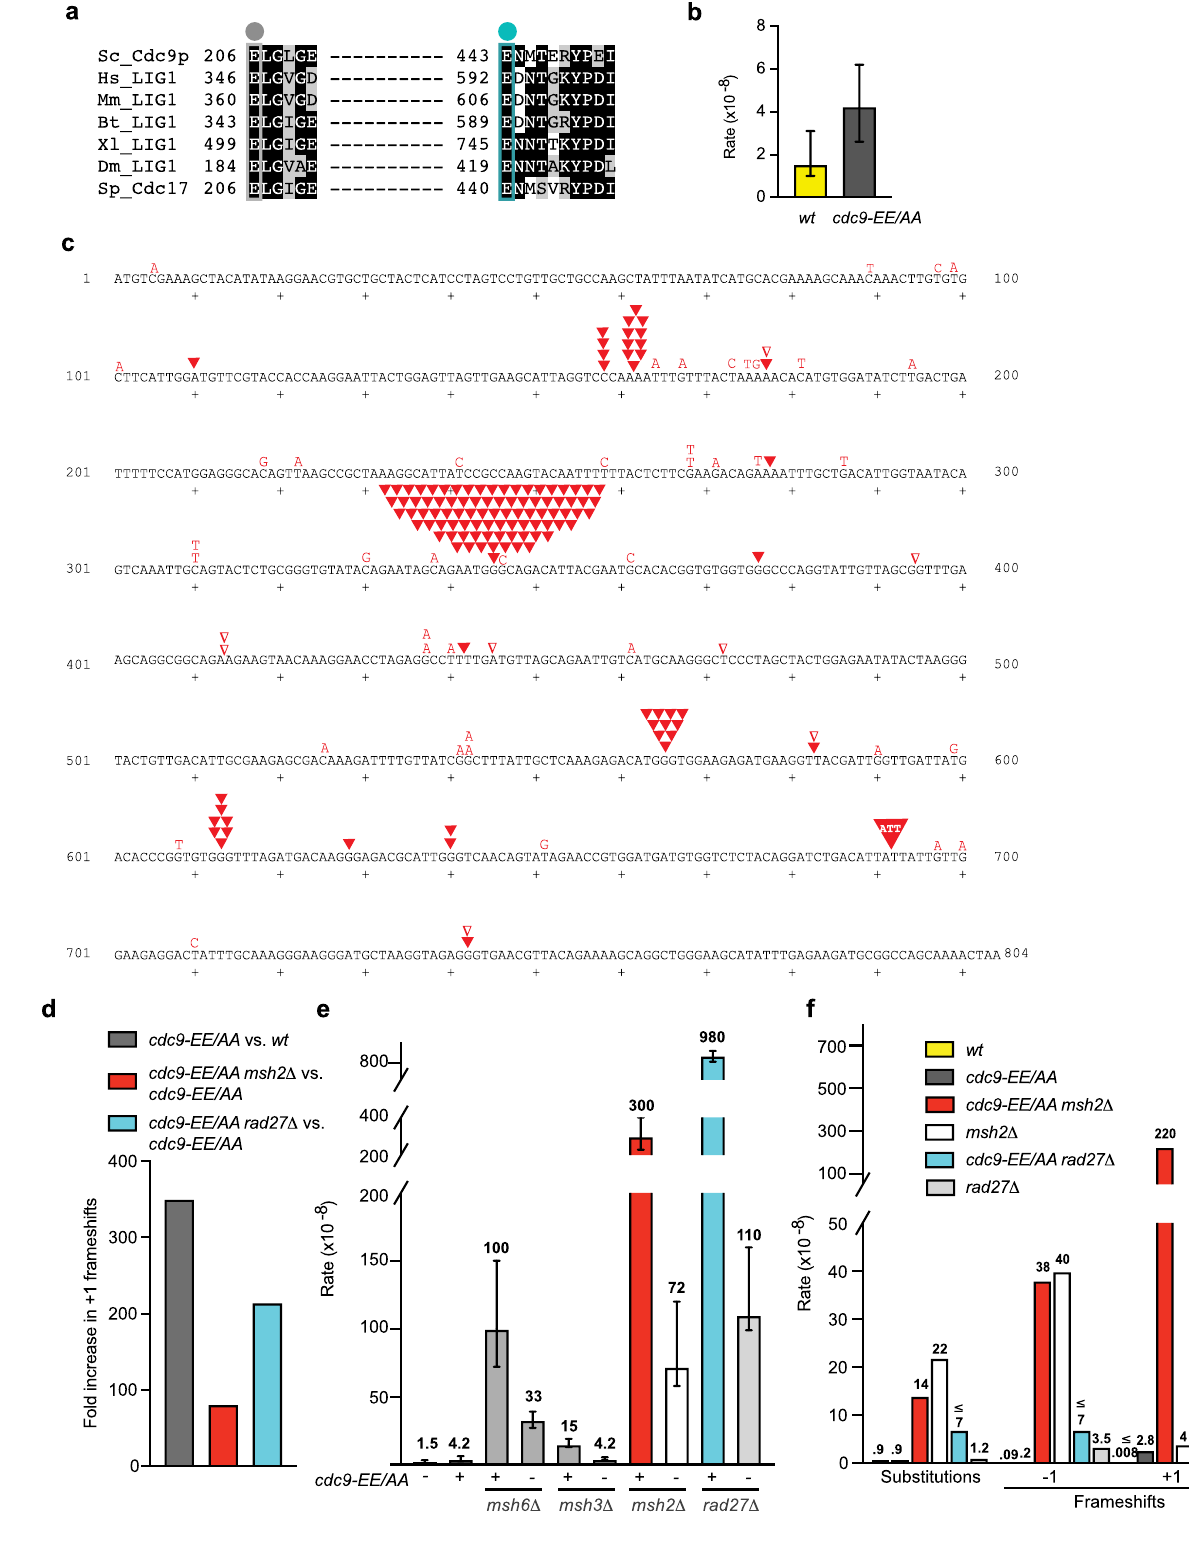
cdc9-EE/AA strain. RAD27 is the gene encoding the Fen1 endonuclease involved in cleaving the displaced DNA fl ap generated by Pol δ displacement synthesis during OFM. Like the cdc9-EE/AA msh2 Δ double mutant, the cdc9-EE/AA rad27 Δ